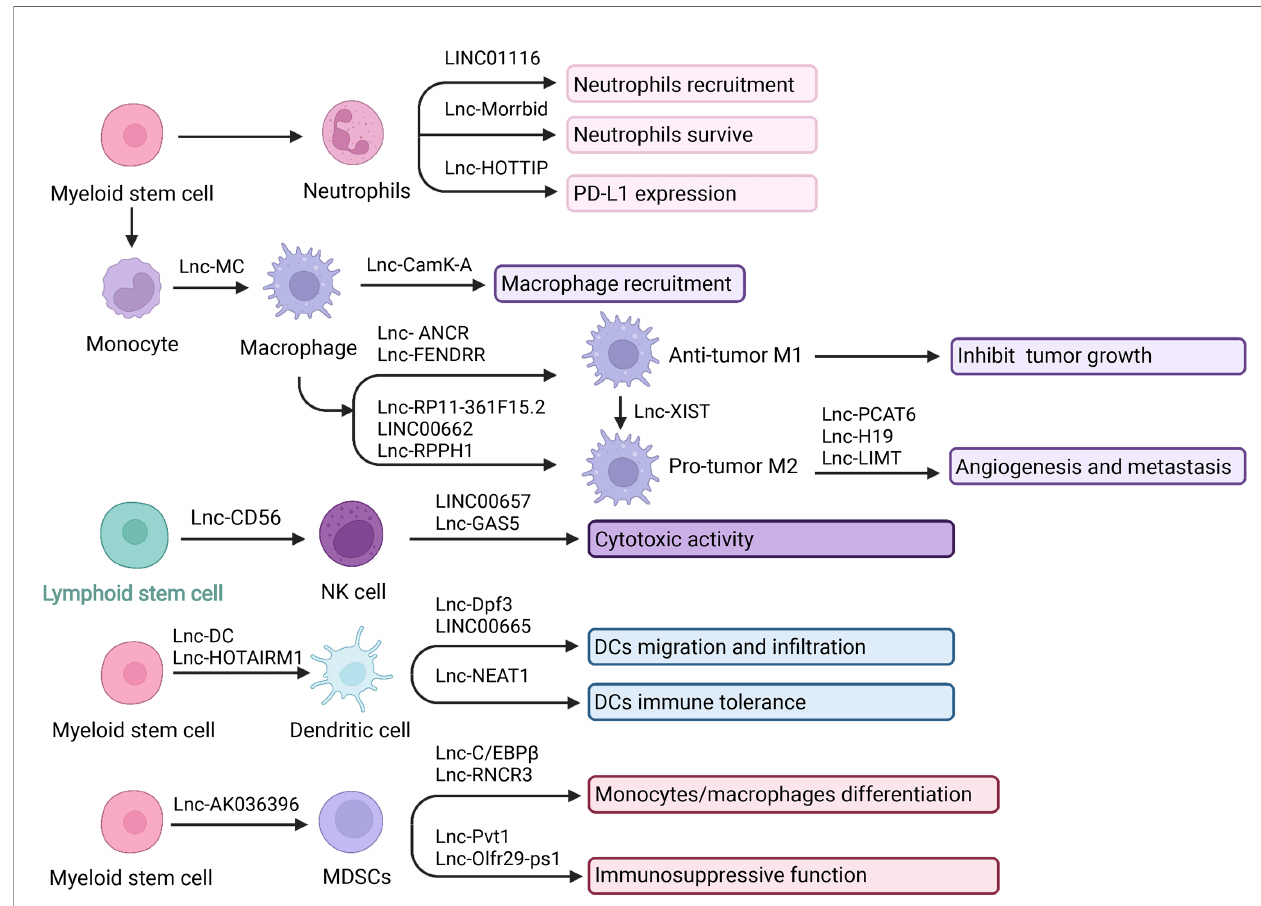
FIGURE 2 | LncRNA and innate immune cellsinTIME. LncRNA is central player incancer biology and they play a pivotal rolein mediatingthe network communication between tumor cells and their microenvironment. Innate immune effectorsincludingneutrophils, macrophages, NKcells, DCs, and MDSCs. LncRNA can interact with tumor- in fi ltrating innate immune cells to modulatetheirrecruitment, development andfunction intumor microenvironment. Created with